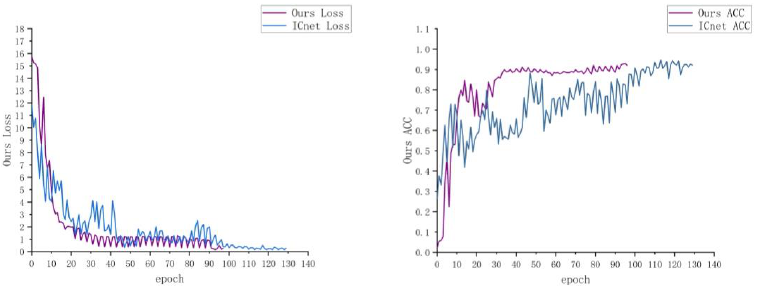
Figure 10. Comparison of loss and ACC curve .